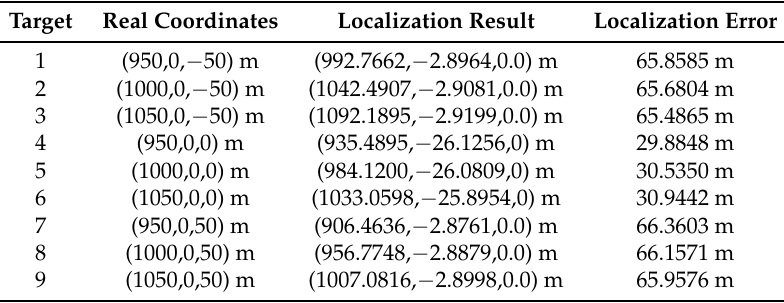
Table 9. Targets localization result proposed in [11,12] with height